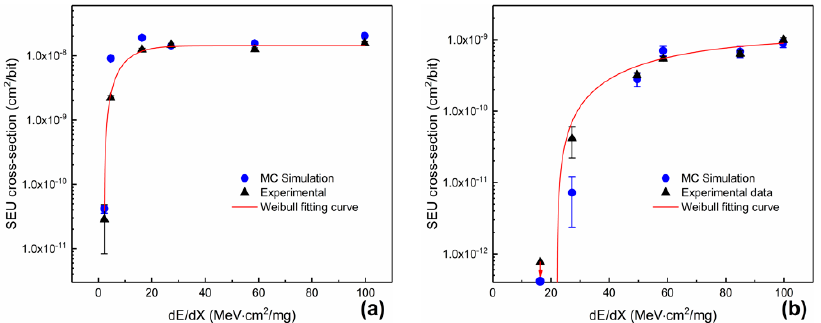
Figure 1. Single-event upset cross-section (CS) as a function of linear energy transfers (LETs) for ( a ) 6T static random-access memory (SRAM) and ( b ) active delay element (ADE) SRAM during dynamic mode testing results.